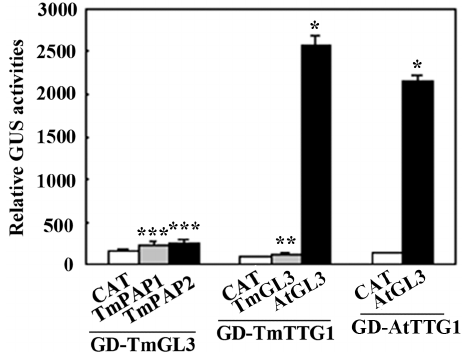
Figure 7. Interaction of the Arabidopsis MBW component proteins and their nasturtium homologs. Plasmids of the GD-fused constructs were co-transfected, respectively, with HA-fused constructs or control construct CAT and the Gal4:GUS reporter construct into protoplasts, and GUS activity was assayed after the transfected protoplasts were incubated for 20–22 h in darkness. Data represent mean ± SD of three replicates. Significant differences from GD control (* p < 0.0001, ** p < 0.01, *** p < 0.05).